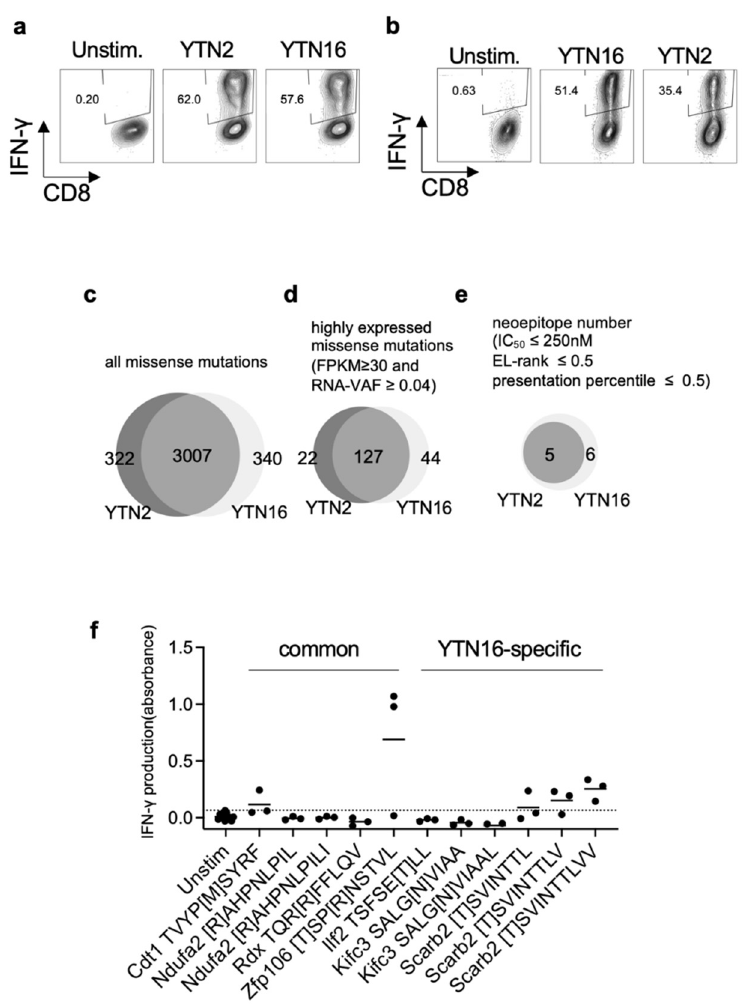
Figure 2. Identification of neoantigens: ( a ) YTN2-reactive CD8 + T cell lines were established from the spleens of mice that had rejected YTN2 tumors. They responded to both YTN2 and YTN16 tumor cells and produced IFN- γ . ( b ) YTN16-reactive CD8 + T cell lines were established from splenocytes of mice that had rejected YTN16 following treatment with anti-PD-1 and/or anti-CTLA-4 mAbs. IFN- γ production by YTN16-reactive CD8 + T cells stimulated with YTN16 or YTN2 was quantified. Venn diagrams indicate ( c ) missense mutations identified by WES, ( d ) expressed mutations filtered by RNA- Seq data (FPKM ≥ 30 and RNA VAF ≥ 0.04), and ( e ) candidate neoepitopes of YTN2 and YTN16 cells. ( f ) YTN16-reactive CD8 + T cell lines were stimulated with 11 candidate peptides. IFN- γ production in the culture supernatant was evaluated by ELISA. Data are based on 3 independently established YTN16-reactive CD8 + T cell lines. A dotted line indicates mean + 2 SD of IFN- γ production by the unstimulated